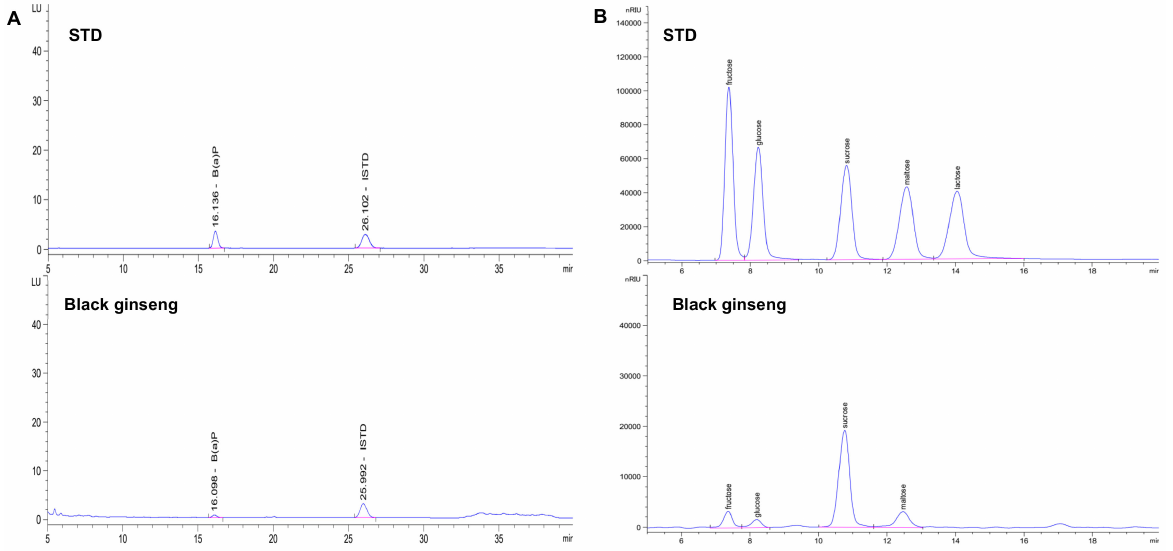
Figure 6. Chromatograms of HPLC-FLD, RID: ( A ) Chromatogram of benzo[ a ]pyrene; ( B ) Chromatogram of free